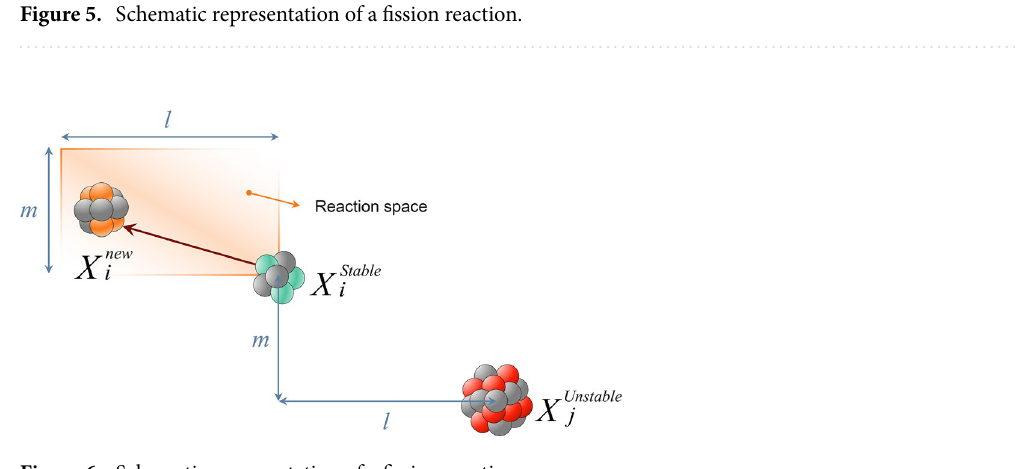
Figure 6. Schematic representation of a fission